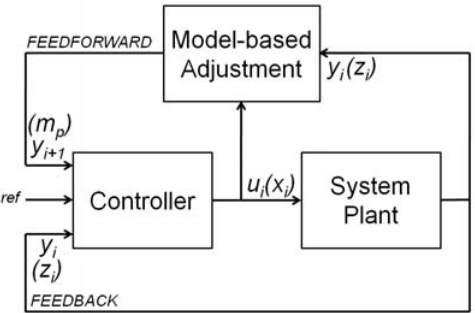
Figure 2. Feedback and feedfordward control scheme. Indexes are the classical nomenclature and the parameters in our system are into